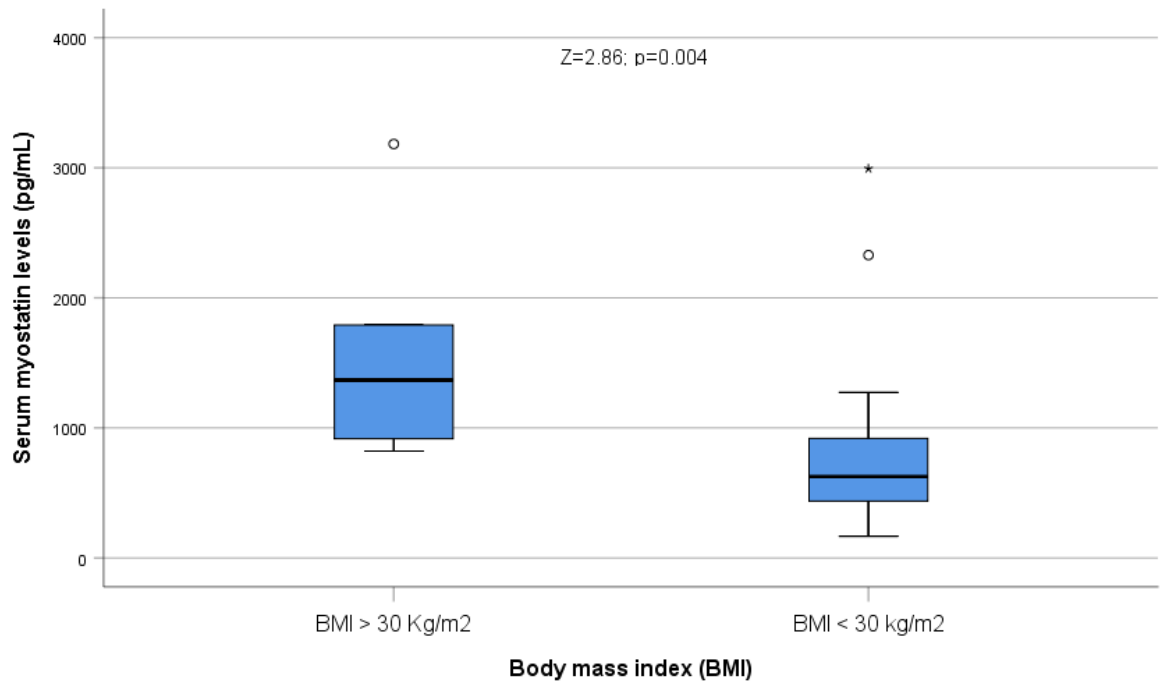
Figure 5. Serum myostatin levels were significantly higher among patients classified as obese according to BMI. Circles correspond to outliers, and asterisks correspond to extreme outliers. A stepwise logistic regression analysis comparing obesity with myostatin, age (both as dichotomic variables according to medians), and cirrhosis showed that myostatin was the only variable independently related to obesity, and the same happened when a mul- tiple correlation analysis was performed between BMI as the dependent variable and my- ostatin, age, and the presence of cirrhosis (Table 3). Table 3. Relationships between myostatin and BMI assessed by stepwise multiple regression anal- yses. Unstandardized Coefficients Standardized Coefficients